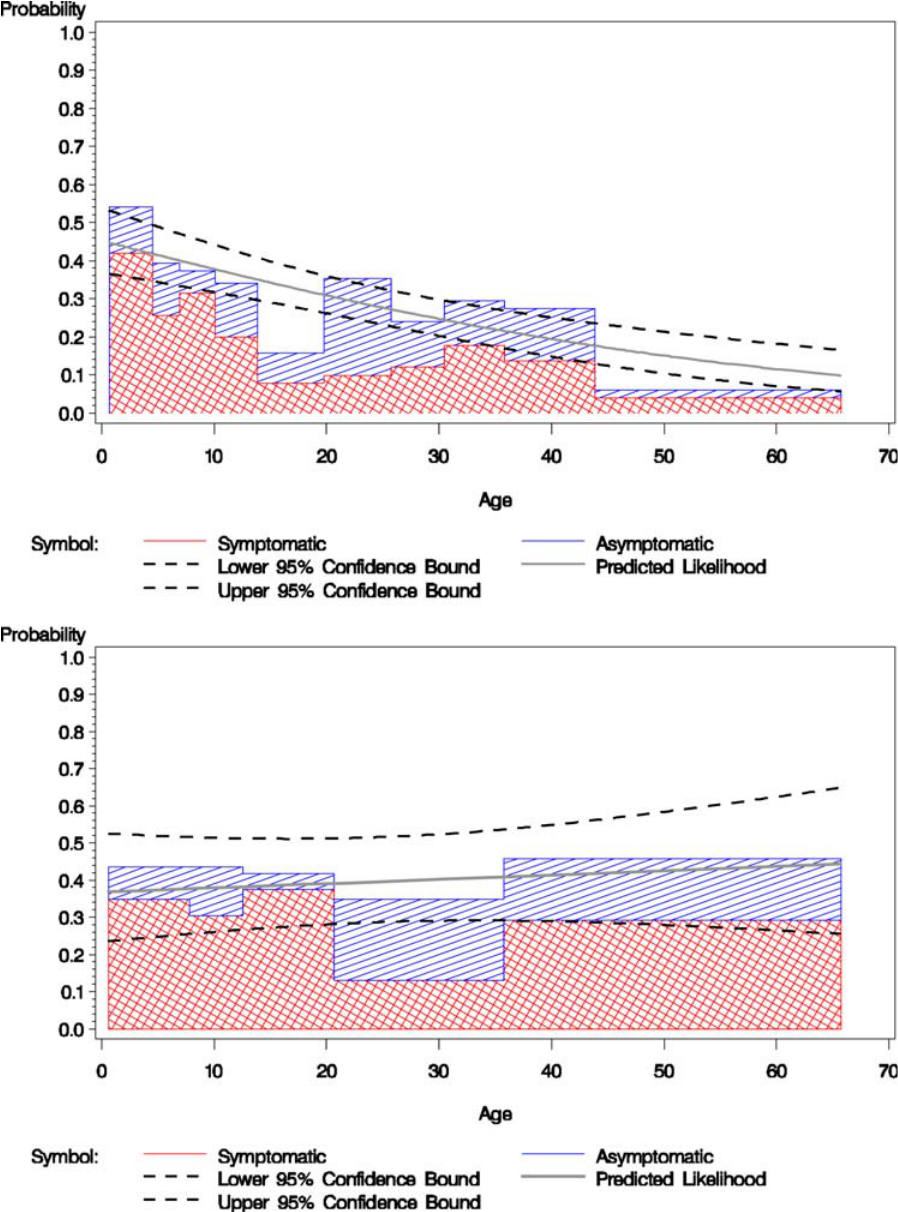
Figure 1. The total proportion of household contacts with definite V.cholerae infection by age group. The red-hatched area indicates those with symptomatic infection, the blue-hatched area indicates those with asymptomatic infection. The associated curves represent the predicted likelihood of developing infection by age based on logistic regression modeling. Figure 1A shows the likelihood of V. cholerae O1 infection by age bound in deciles (P for predicted model , 0.0001). 1B shows the likelihood of developing V. cholerae O139 infection according to age bound in quintiles (P for predicted model=0.6).